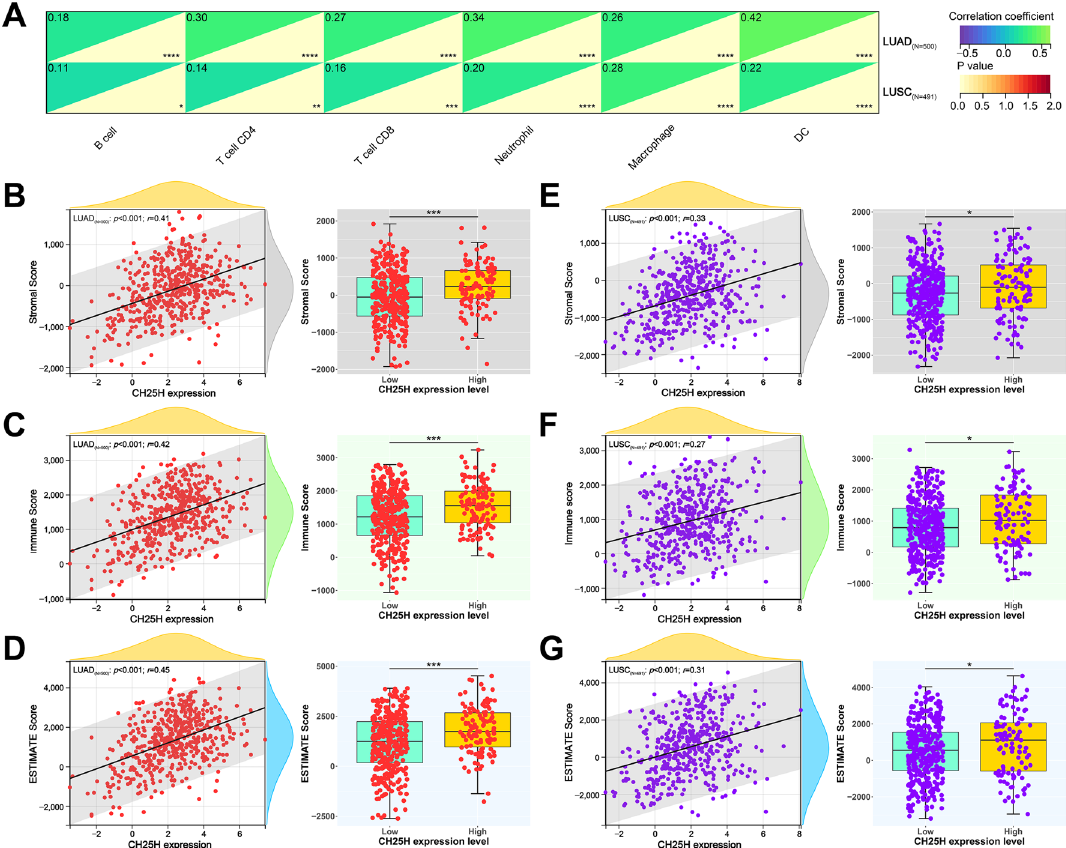
Figure 3. CH25H immune infiltration. ( A ) CH25H expression levels had a significant positive association with the infiltration level of B cells, CD4 + T cells, CD8 + T cells, dendritic cells, macrophages and neutrophils in LUAD; ( B – G ) the expression levels of CH25H had a significant positive relationship with the immune score of LUAD samples. Box plots were generated by R package “ggplot2” using data from Sangerbox. “*”, and “***” indicate p < 0.05, and p < 0.001,